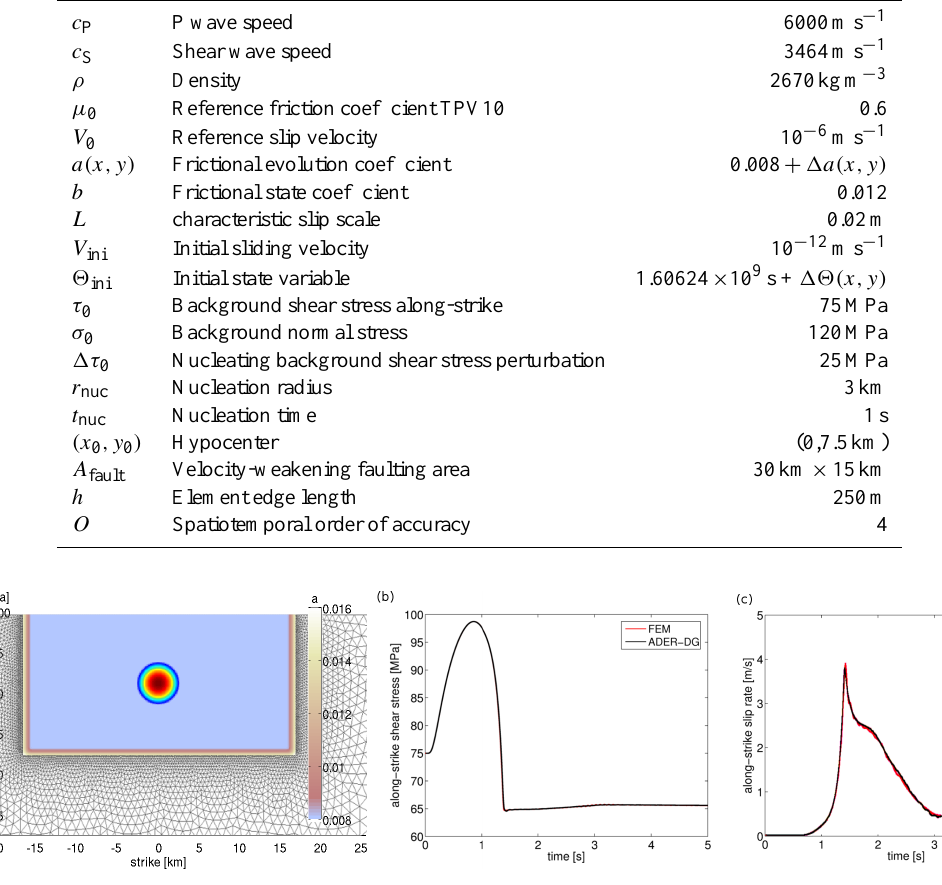
Table 5. Simulation parameters for SCEC test case TPV101.